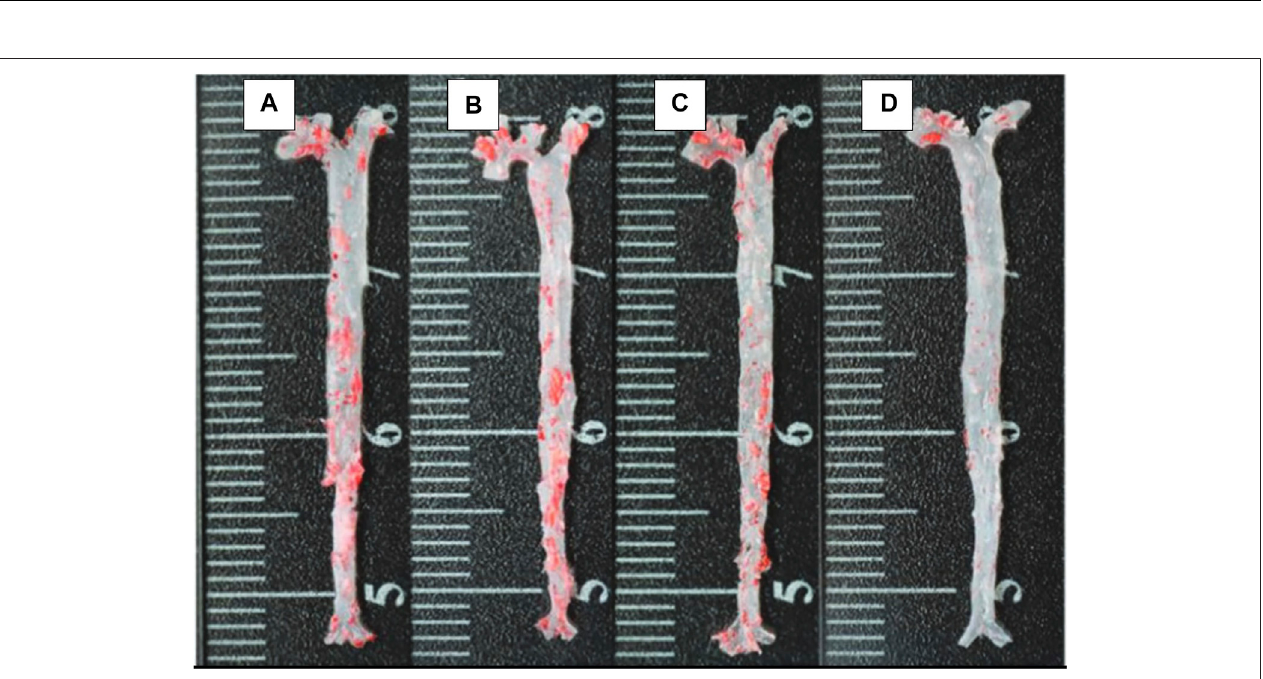
FIGURE 8 | The ORO-stained images of aortas from each group (A) control; (B) free drug; (C) RAP@PLGA; and (D) RBC/RAP@PLGA. Adapted from Wang et al. (2019b). Copyright @ 2019 (Wiley).